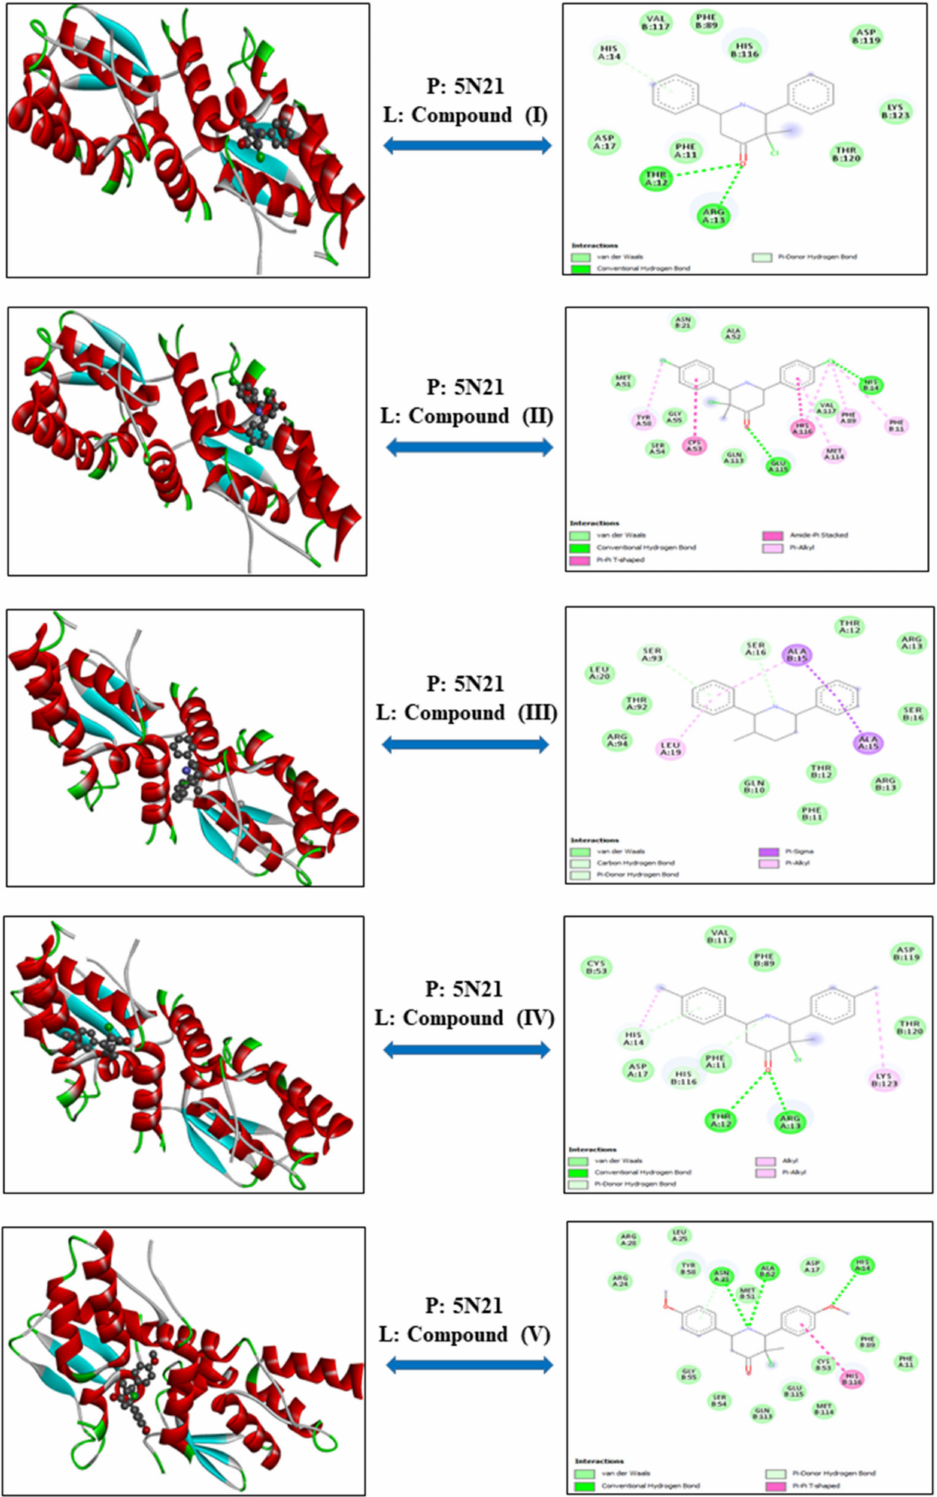
Figure 4. Compounds I – V (ligands) and 5N21 (protein) are all best-docked positions, and the right side shows the lowest-energy 2D